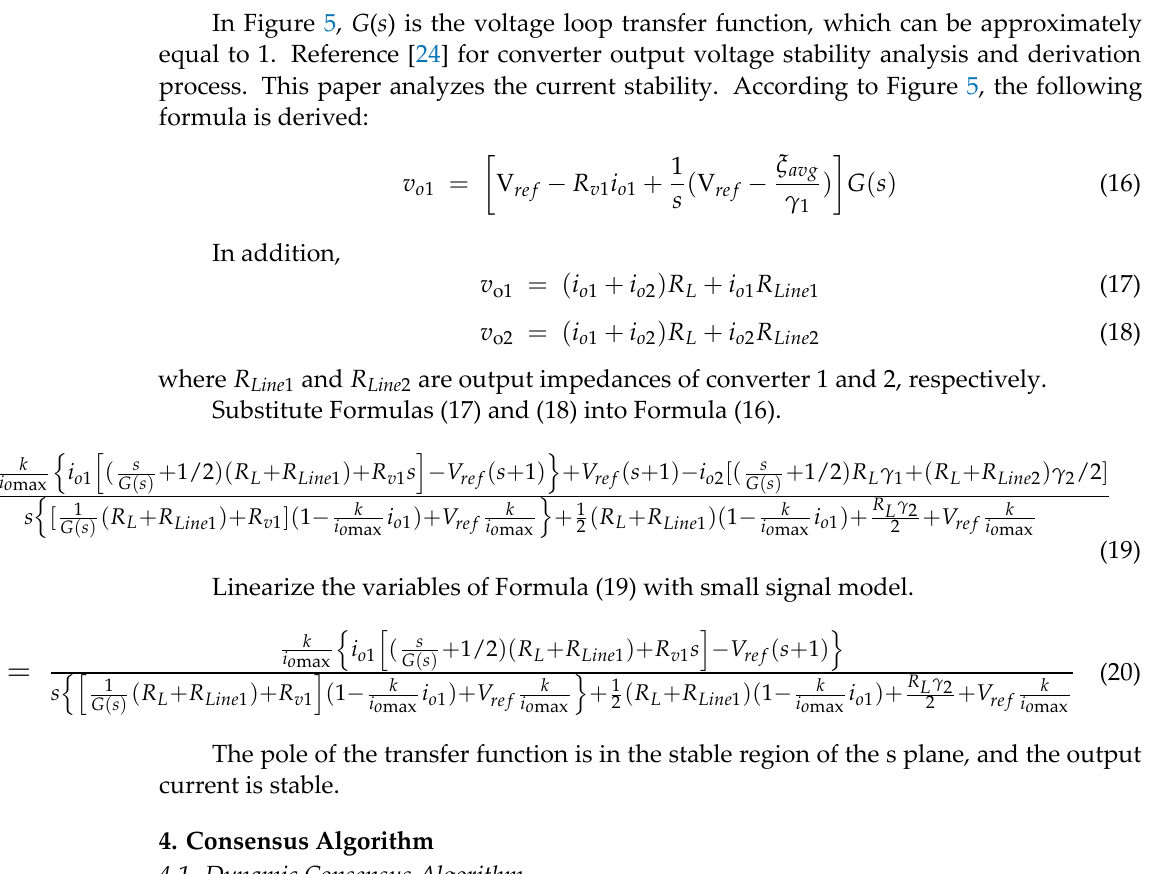
Figure 5. Equivalent model for stability analysis.